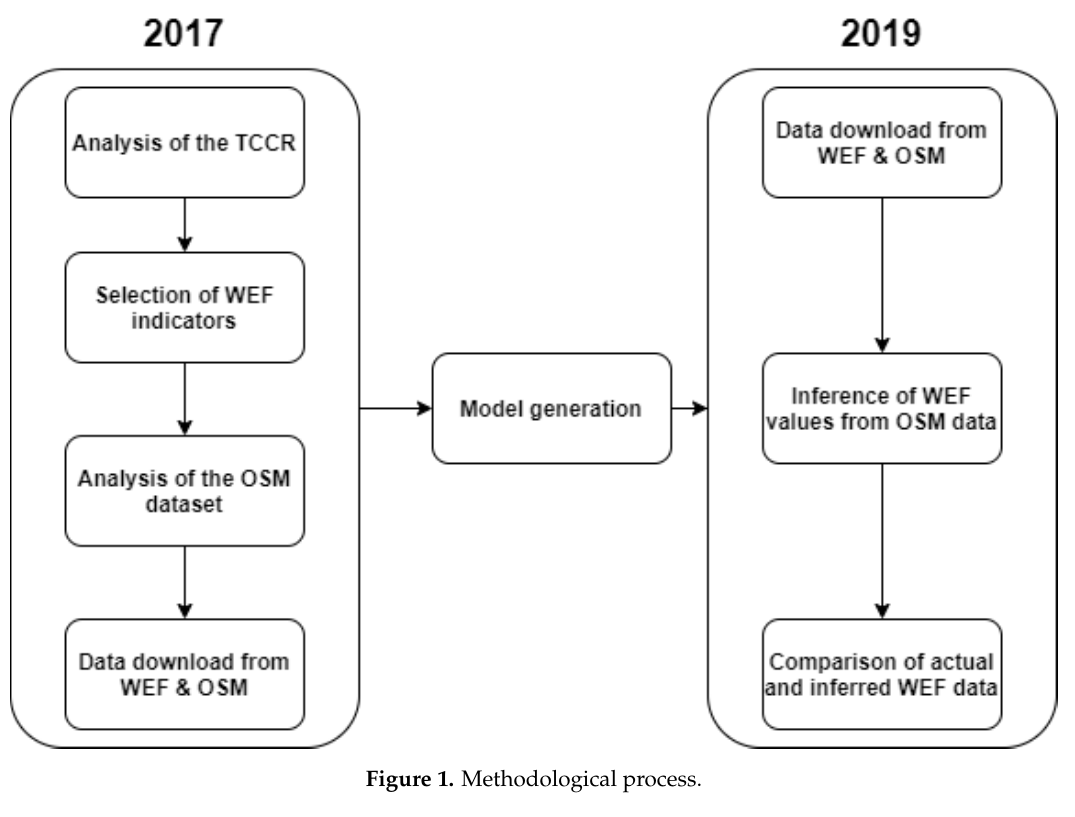
Figure 1. Methodological